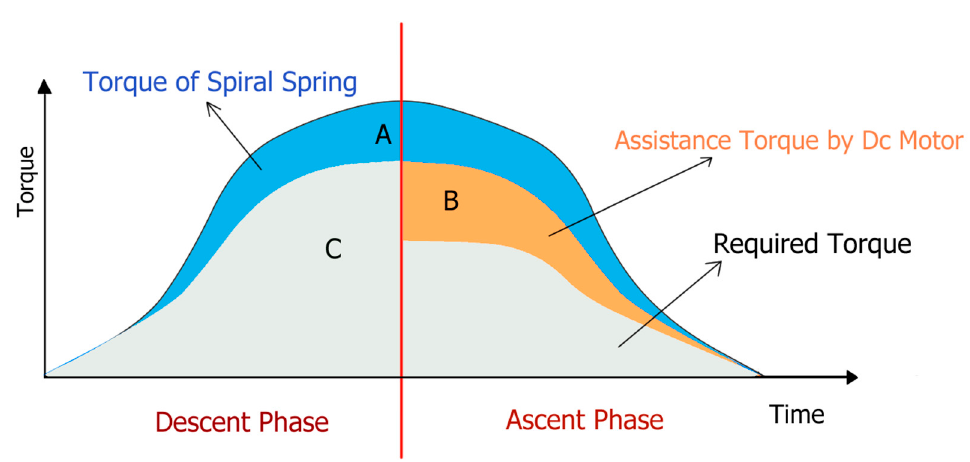
Figure 14. Theoretical illustration of the change in torque requirement of a human body when using ES ‐ RSEA.